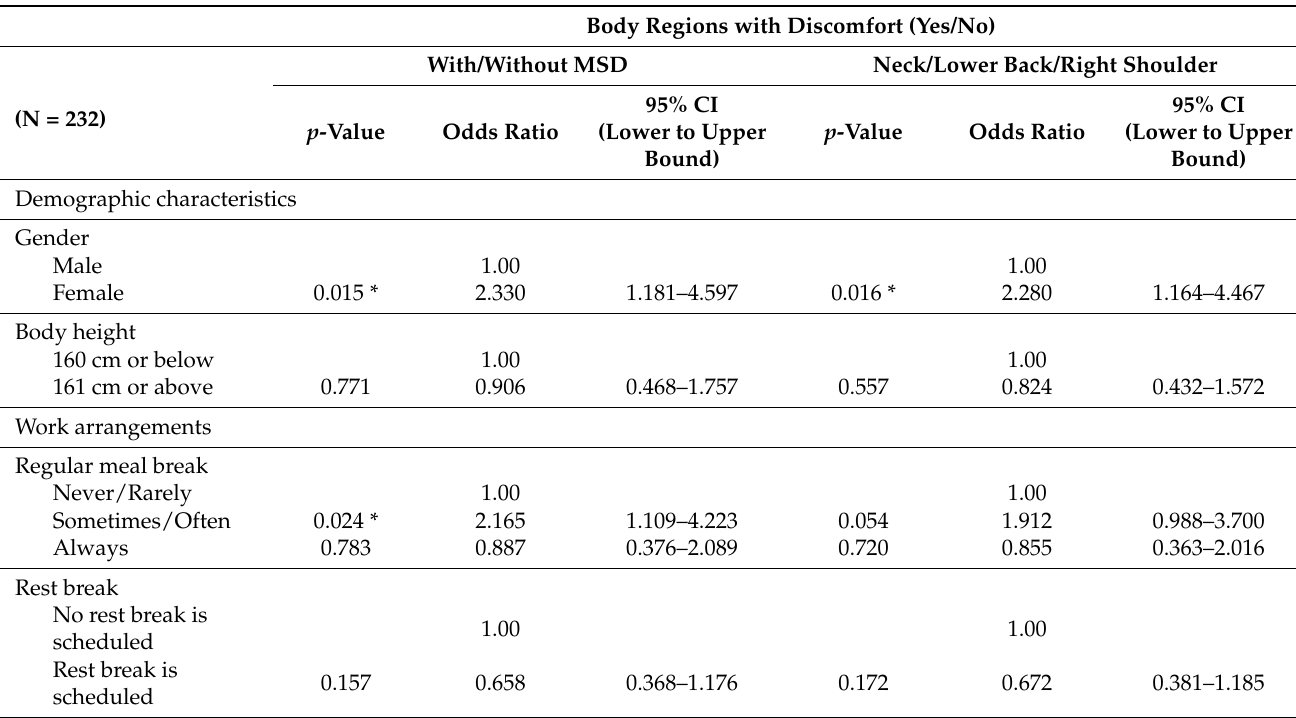
Table 7. Summary of multivariate logistic regression analyses for demographic characteristics and work arrangements and self-reported musculoskeletal discomfort.